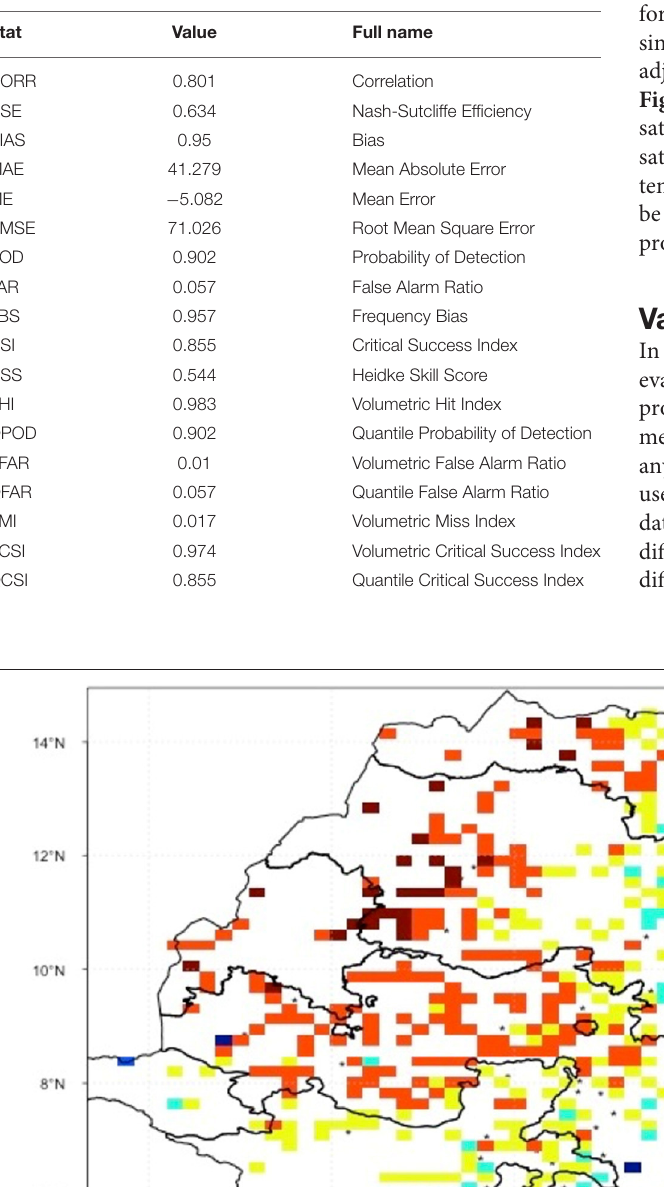
TABLE 3 | Validation outputs.